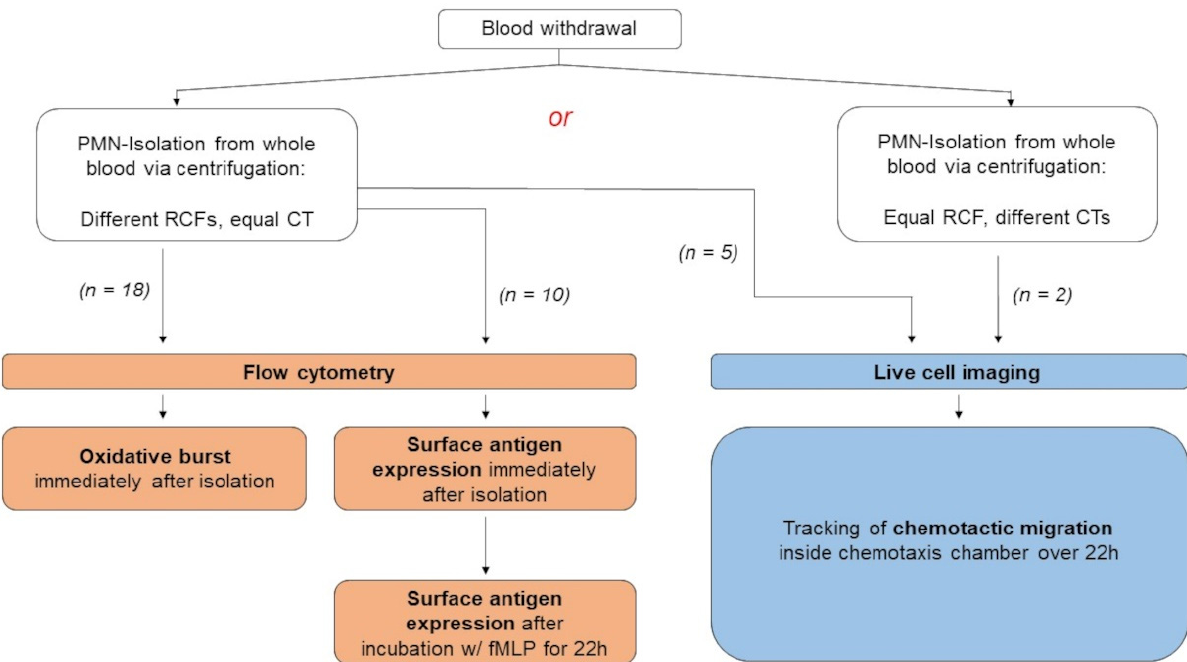
Figure 1. Schematic presentation of the methods used in this study. In one setup, centrifugation is performed with different relative centrifugal forces (RCFs) but one centrifugation duration (CT). In the other setup, centrifugation features equal RCF but different CTs. For examination of surface antigen expression, isolated cells are incubated with chemoattractant n-formylmethionyl-leucyl- phenylalanine (fMLP).